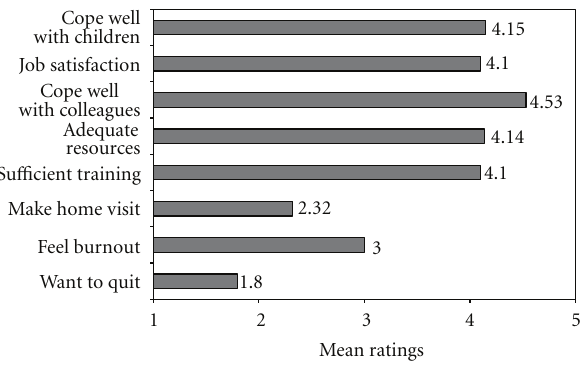
Figure 2: Mean ratings (1 = never to 5 = always) for job condition variables.